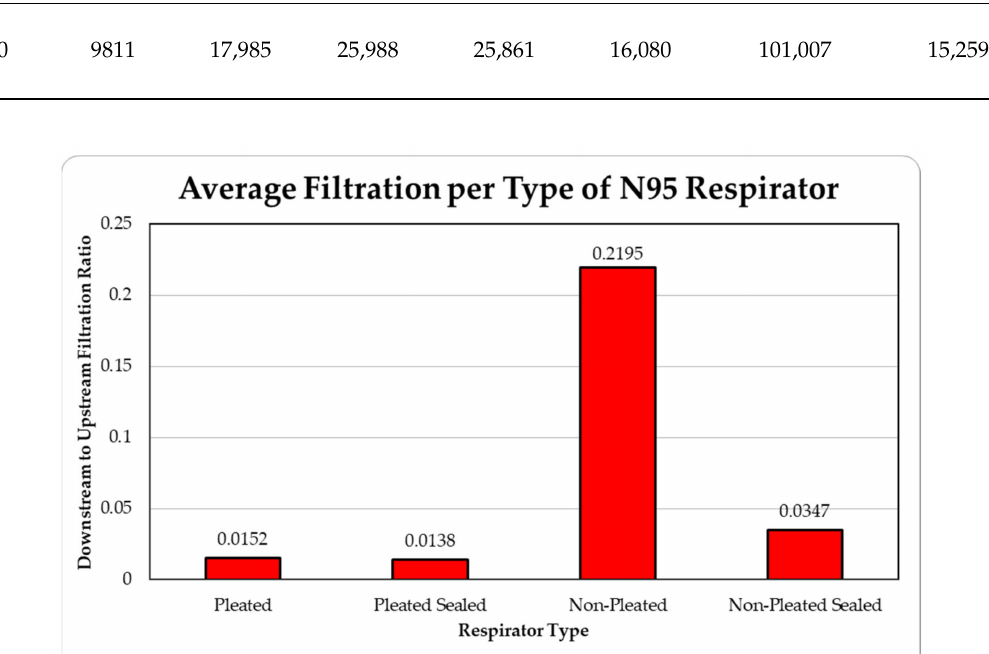
Figure 11. Average filtration ratios of total particles per type of respirator at the Carruth Weld- ing Shop.